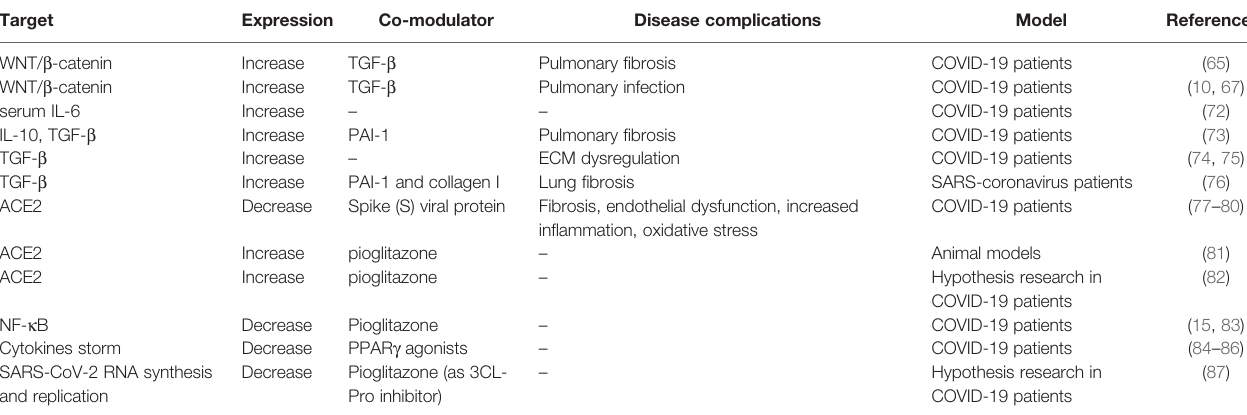
TABLE 1 | Mechanisms by which the WNT/ b -catenin pathway is modulated and the possible roles of PPAR g agonists in treating SARS-CoV-2